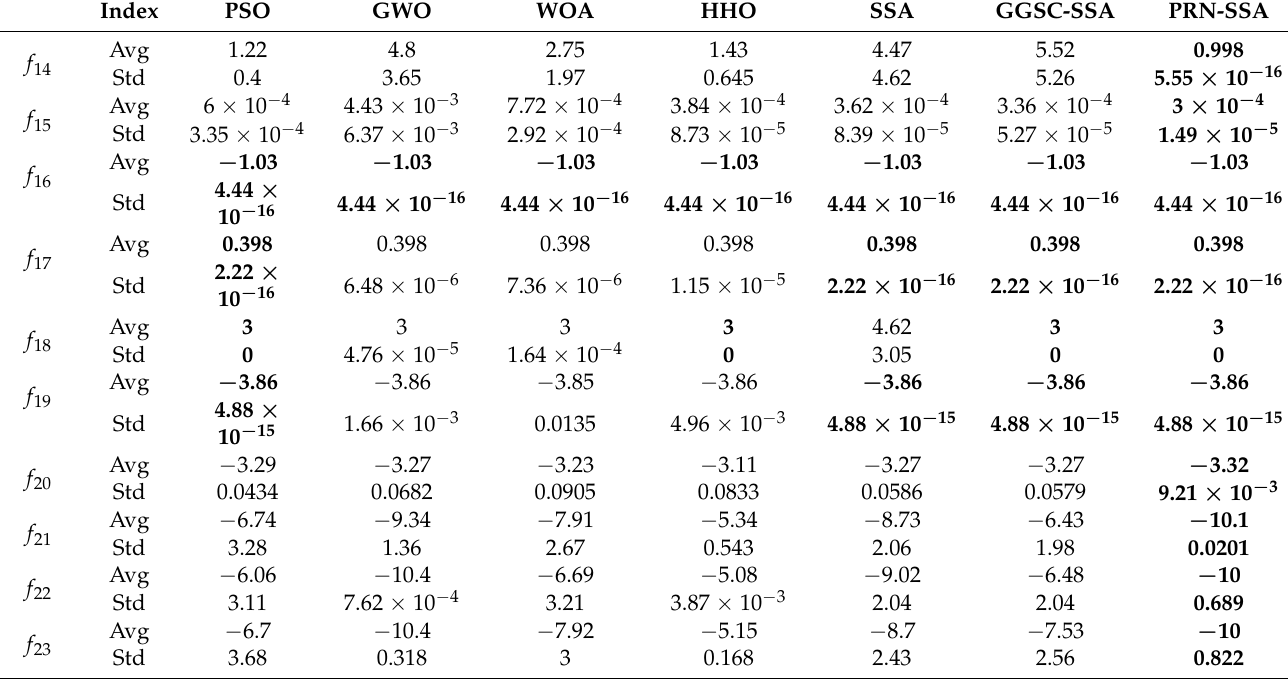
Table 6. Fixed dimension multimodal test